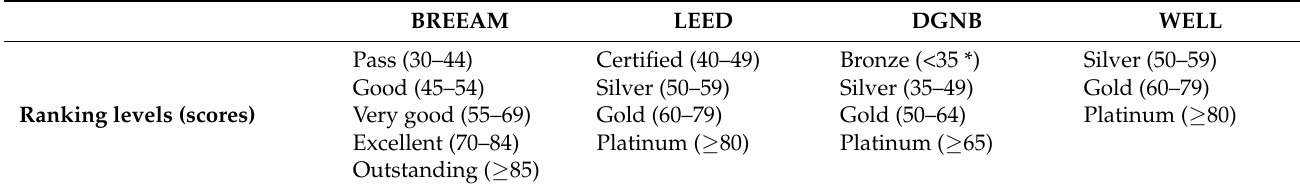
Table 4. Scales of assessments in the systems of international “green”